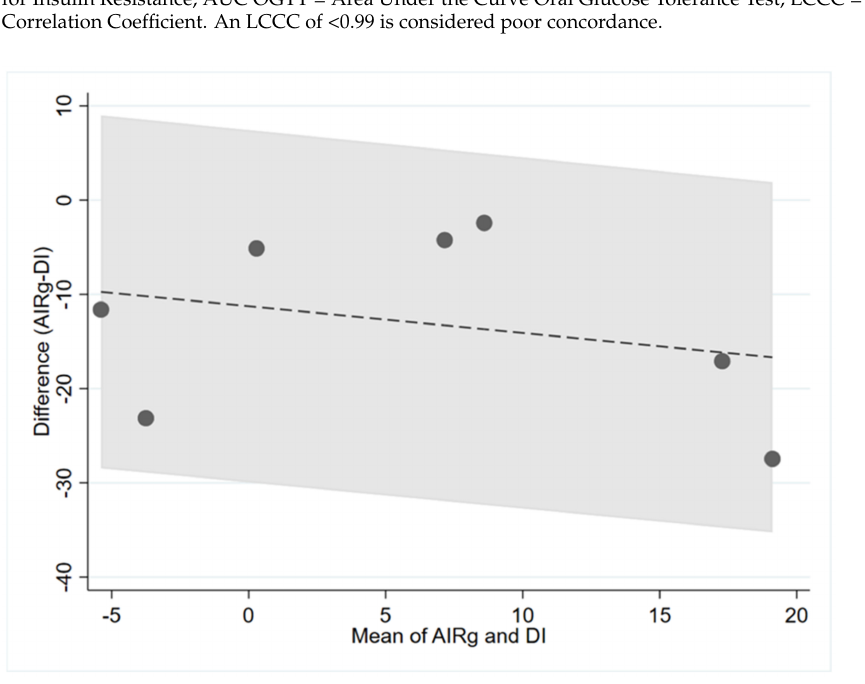
Figure 2. Bland–Altman plots between of AIRg vs. DI (insulin secretion). The central dashed line rep- resents the mean difference between measures represented as log values. The area in grey represents the 95% confidence intervals. AIRg = acute insulin response to glucose, DI = disposition index.